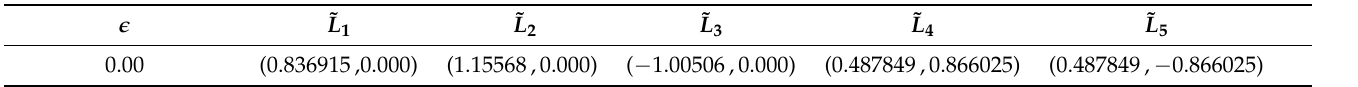
Table 1. Values of unperturbed Lagrangian points.